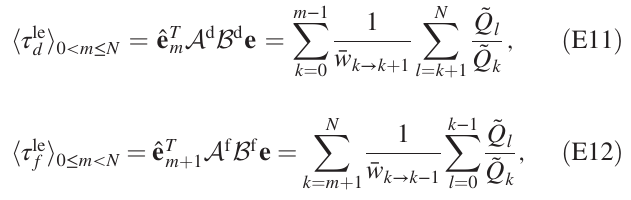
g in Eq. (21) for the i